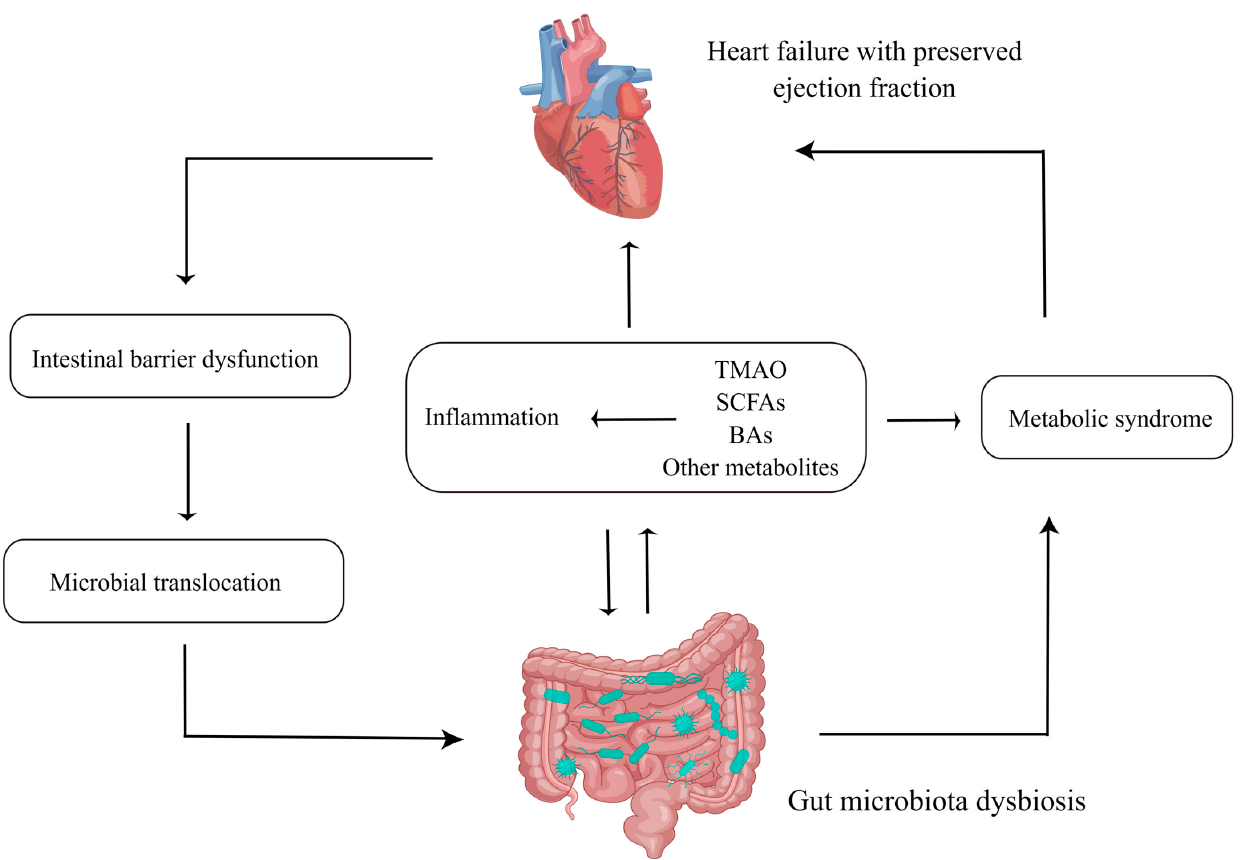
Figure 1. Gut microbiota (GMB) interacts with heart failure with preserved ejection fraction in multiple ways. Abbreviations: TMAO, trimethylamine N-oxide; BAs, bile acids; SCFAs, short-chain fatty acids. This figure was made by Figdraw.